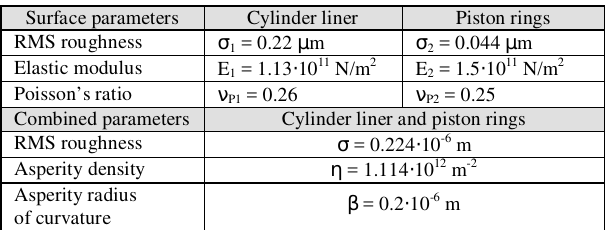
Table 3. Surface roughness parameters Surface parameters